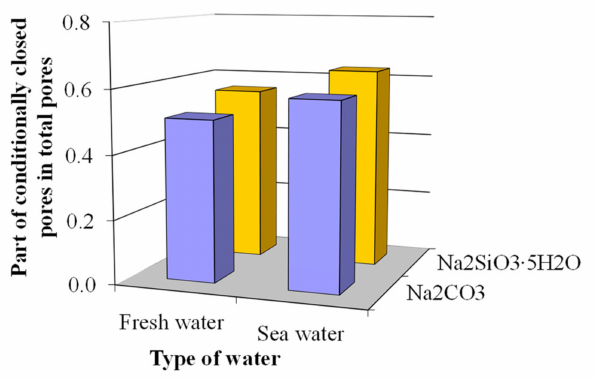
Figure 12. Specific volume of conditionally closed pores in the plasticized concrete based on blast furnace cement.